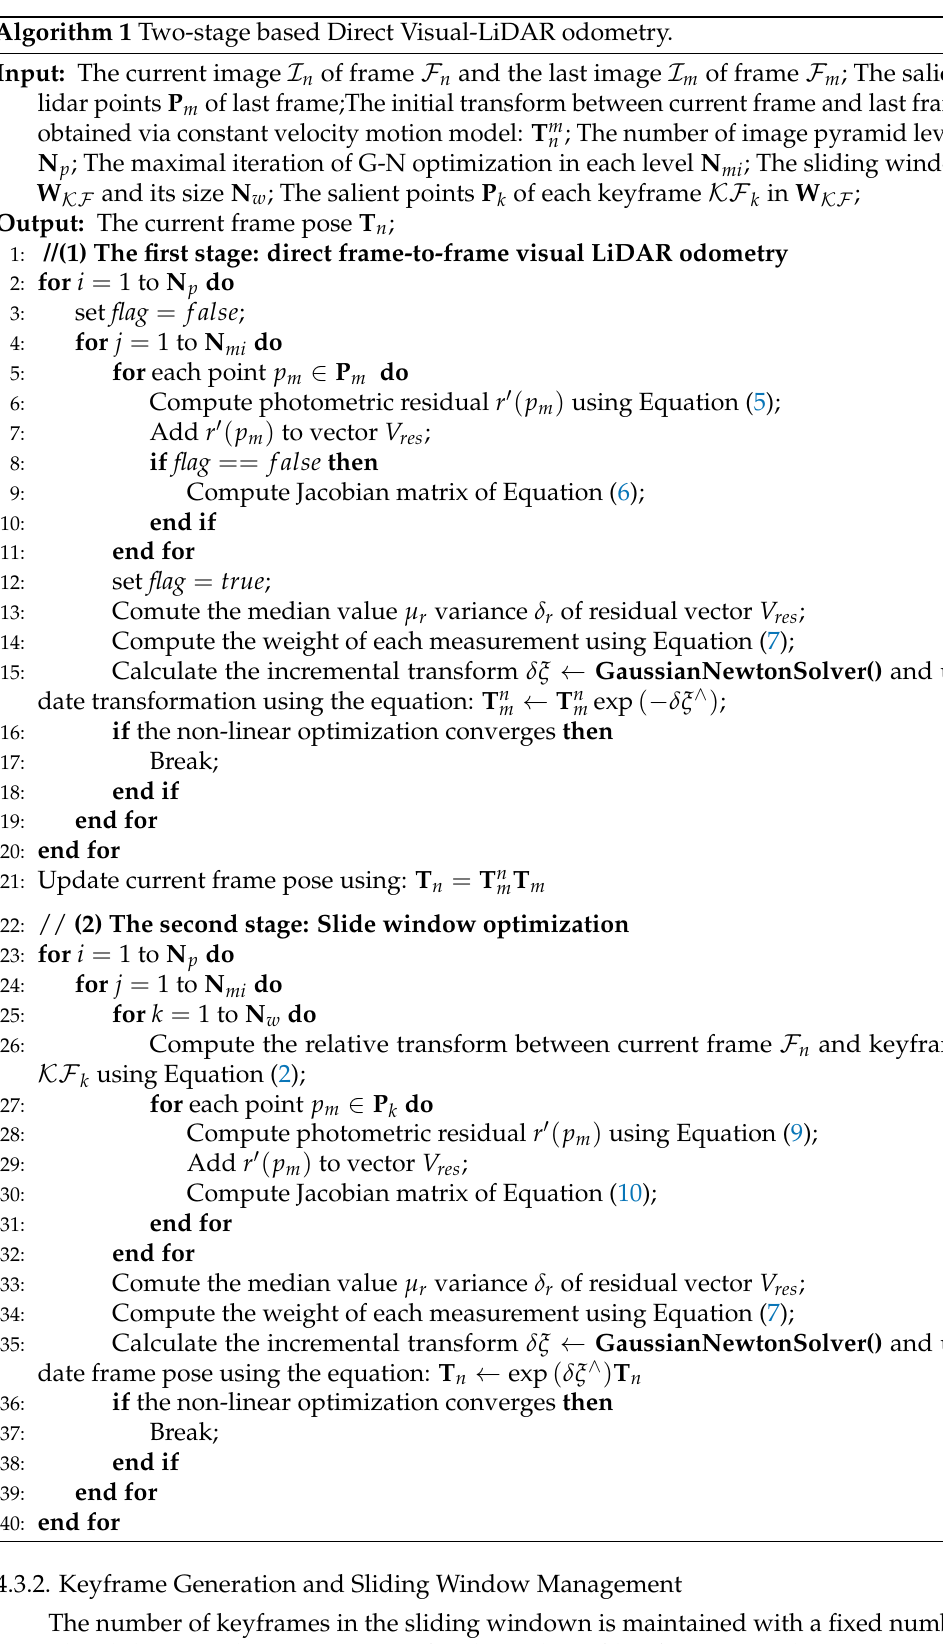
Algorithm 1 Two-stage based Direct Visual-LiDAR